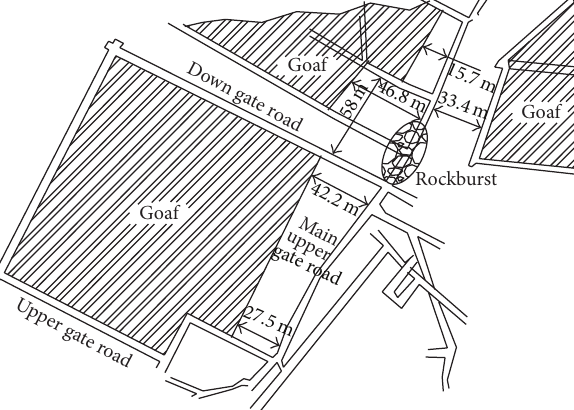
Figure 13: Rockburst region at the ending stage of the